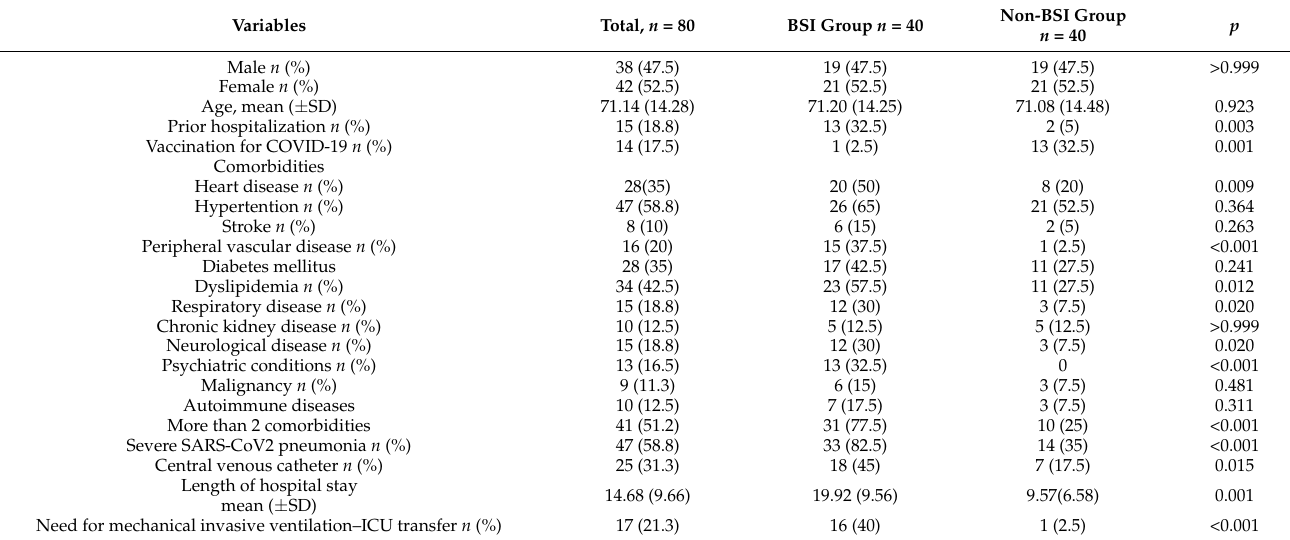
Table 2. Case-control analysis of clinical characteristics of patients with COVID-19 between BSI and non-BSI groups. Bold means statistical significant values.